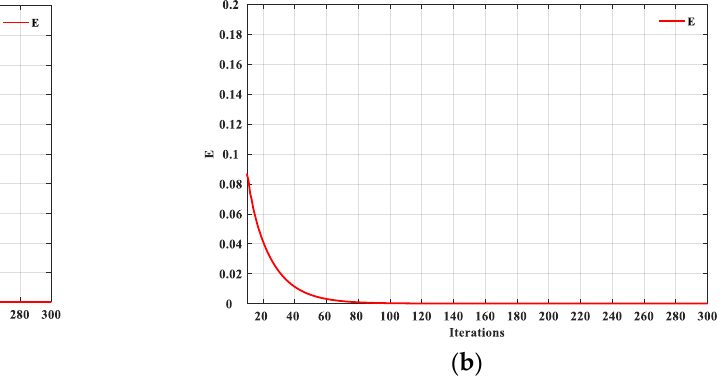
Figure 5. ( a ) E(I) with the ETC. ( b ) E(I) without the ETC.